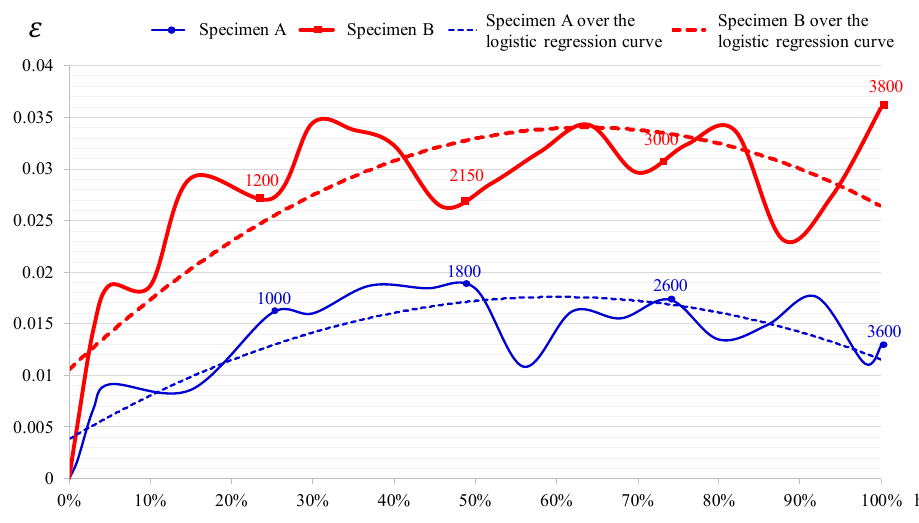
Figure 8. Correlation between humidity and strain (tile deterioration).